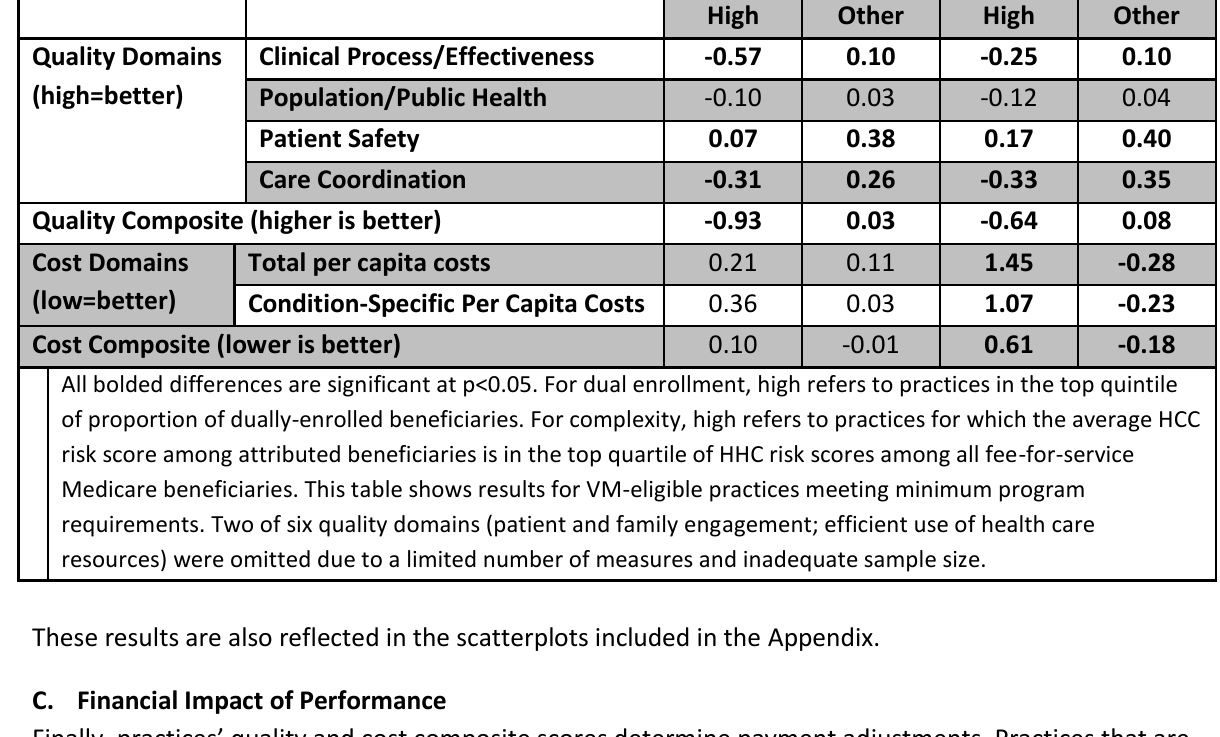
Table 10.13a/b. Value Modifier by High-Dual or High-Complexity Practice vs. Other Practice, Among VM-Eligible Practices Meeting Program